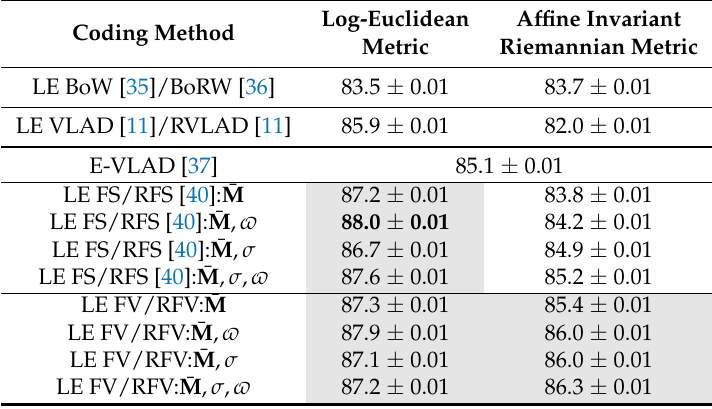
Table 5. Classification results on the Outex database (68